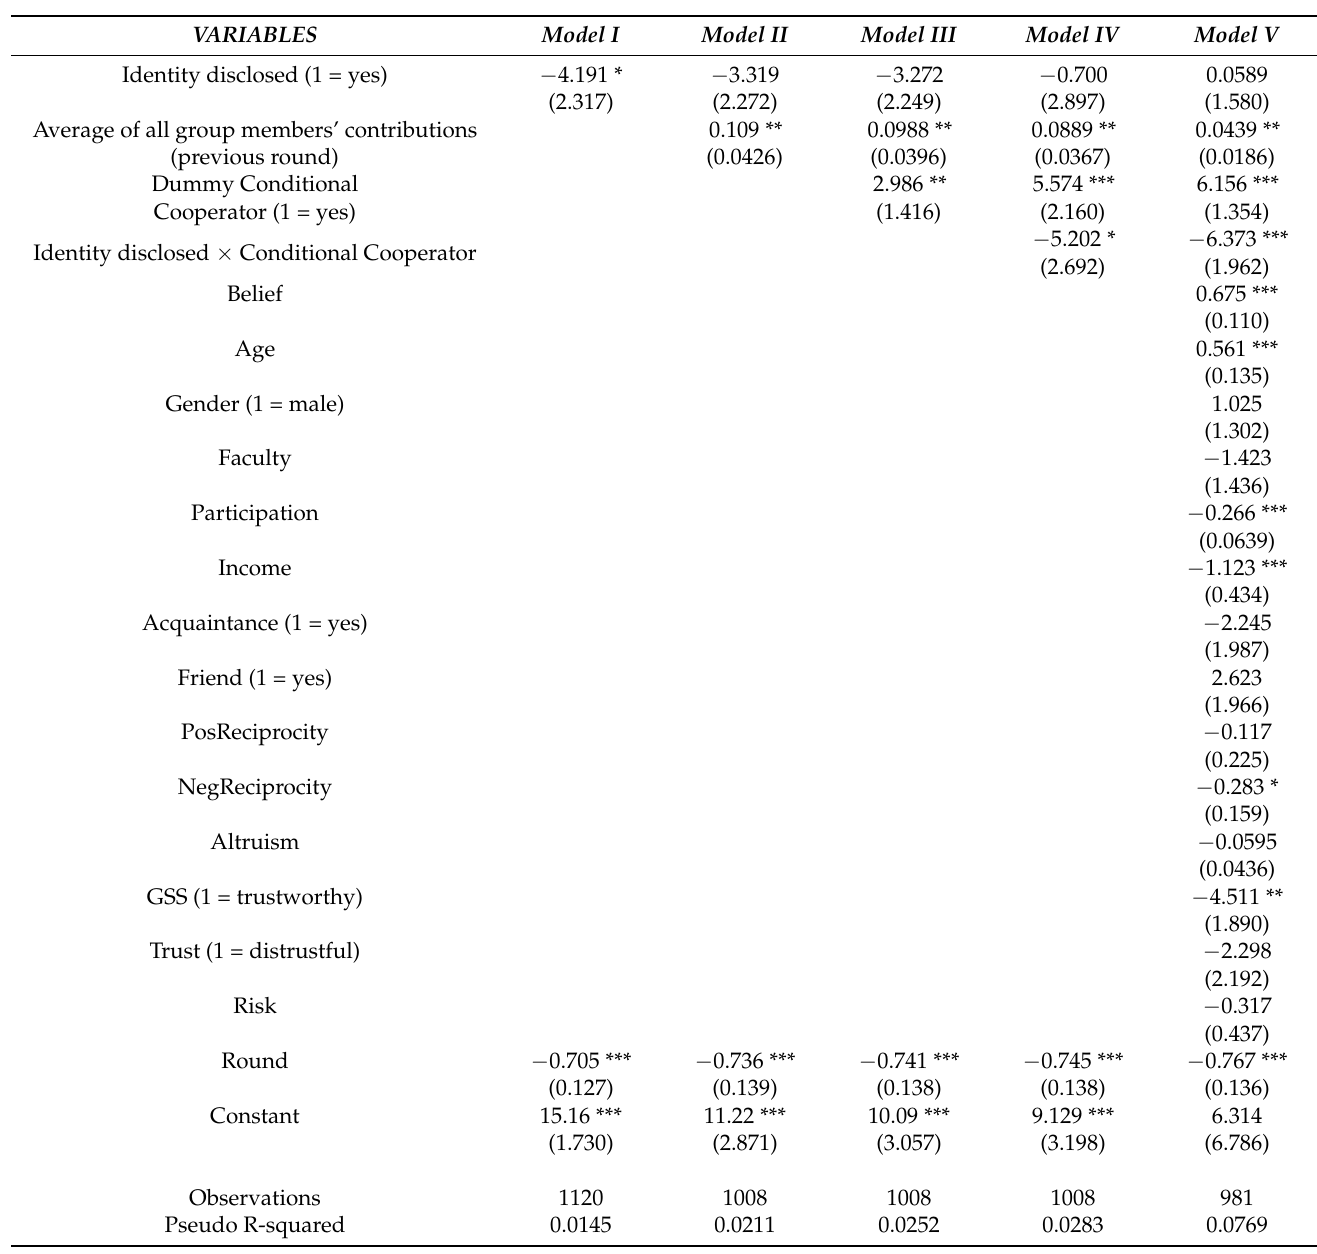
Table A6. ExtDon setting: Tobit regression on individual contribution showing